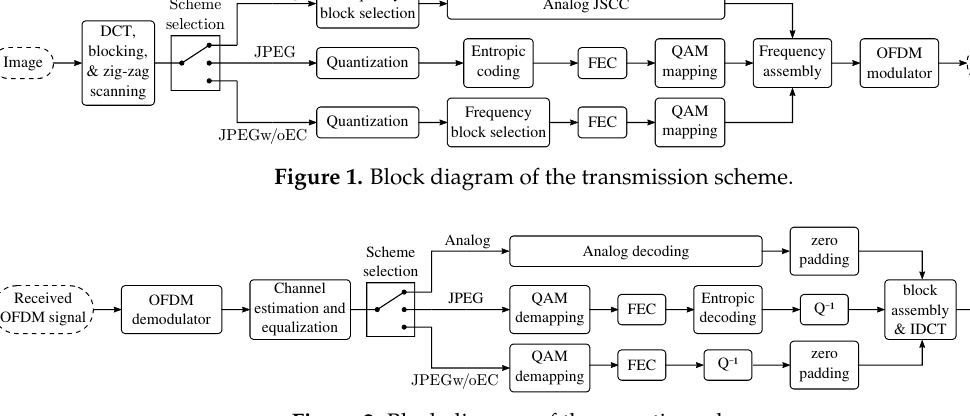
Figure 2. Block diagram of the reception